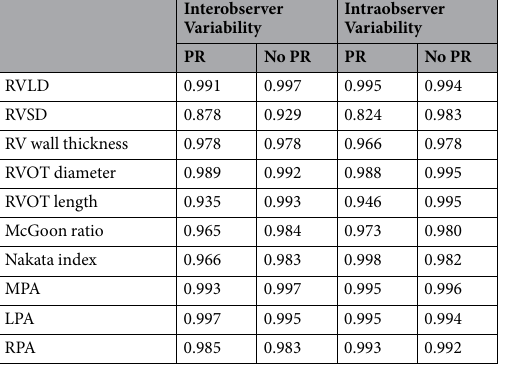
Table 3. Interobserver and Intraobserver variability of diameters and indexes. Note: Abbreviations as in Table